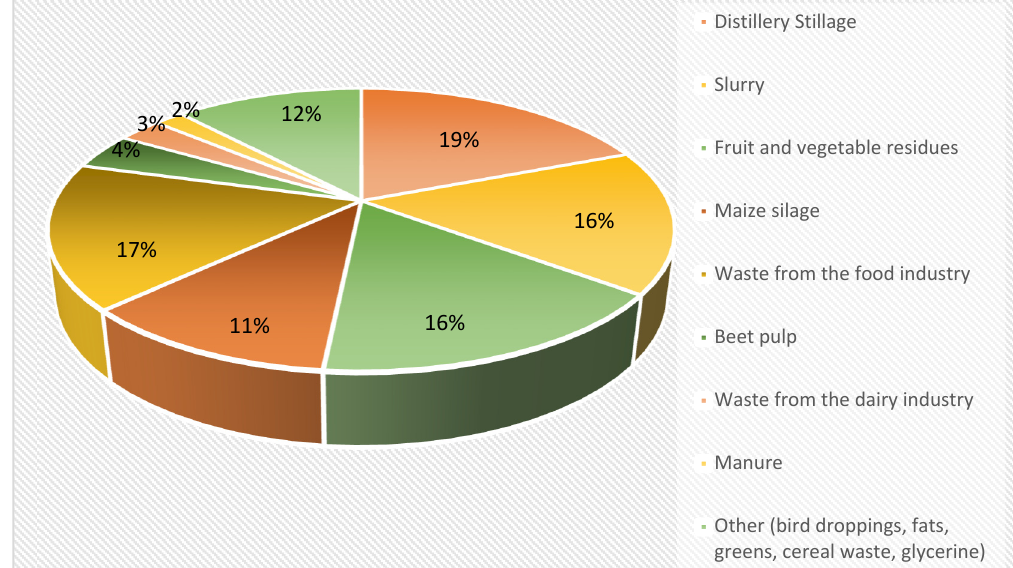
Figure 1. Raw materials used for agricultural biogas production in 2021 in Poland. Own elaboration according to data [22,23].